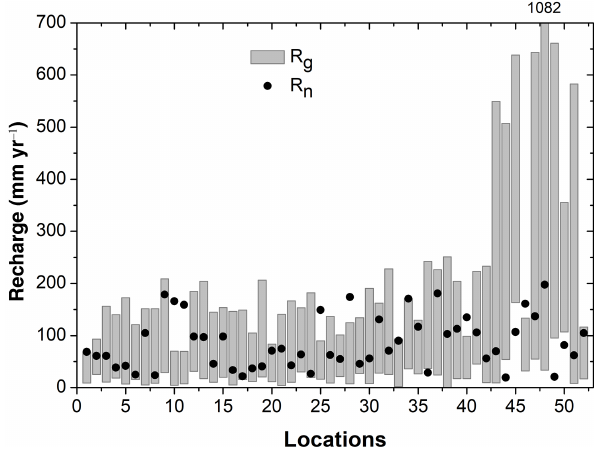
Figure 10. Comparison of groundwater recharge rates obtained from the present study (annual range) and some of the earlier stud- ies conducted over the point locations shown in Fig. 1. Recharge estimates exceeding 700mmyr − 1 data are indicated on the top of the